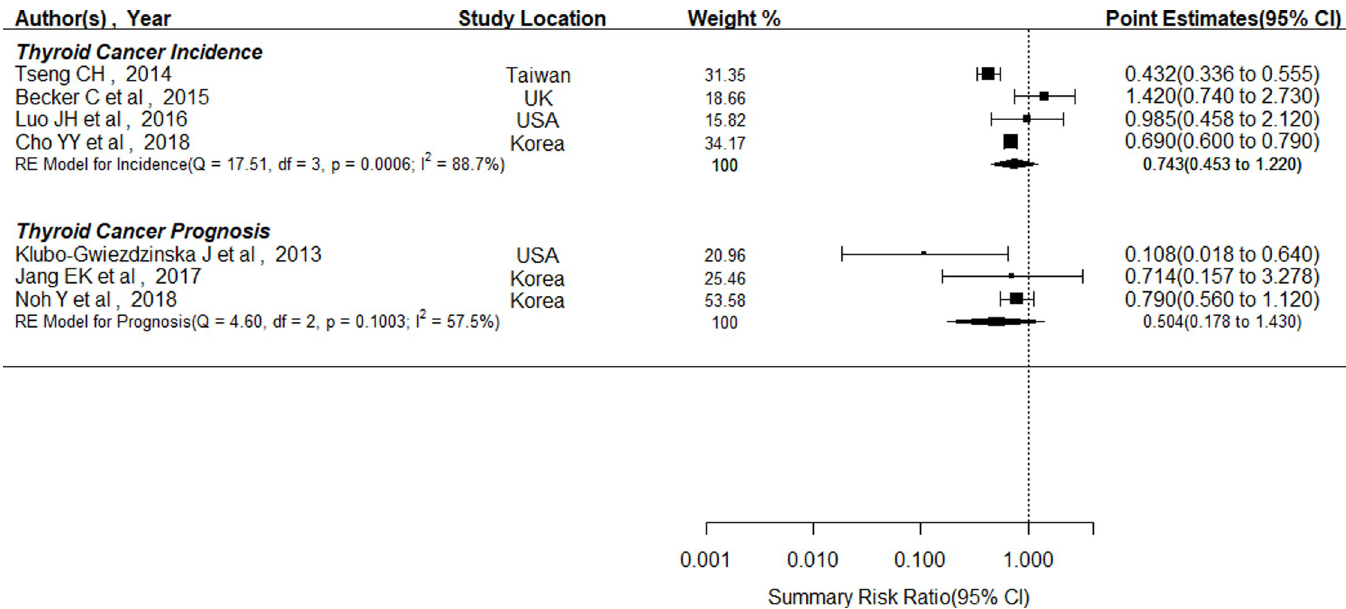
Fig 2. Forest plot of associations between metformin, incidence and prognosis of thyroid cancer a,b . a : Black boxes denote point estimates for HRs and ORs, and horizontal lines represent 95% CIs. Black diamonds, Summary risk ratio (SRR) estimates. No association under the null hypothesis (risk estimate equal to 1.00) was represented by the vertical dotted line. b :Incidence studies: [29, 30, 33, 34]; Prognosis studies: 1) Klubo-Gwiezddzinska J et al, [35] the progression-free survival of thyroid cancer; 2) Noh Y et al, [31] the metastasis of thyroid cancer; 3) Jang EK et al, [36] the recurrence of thyroid cancer.